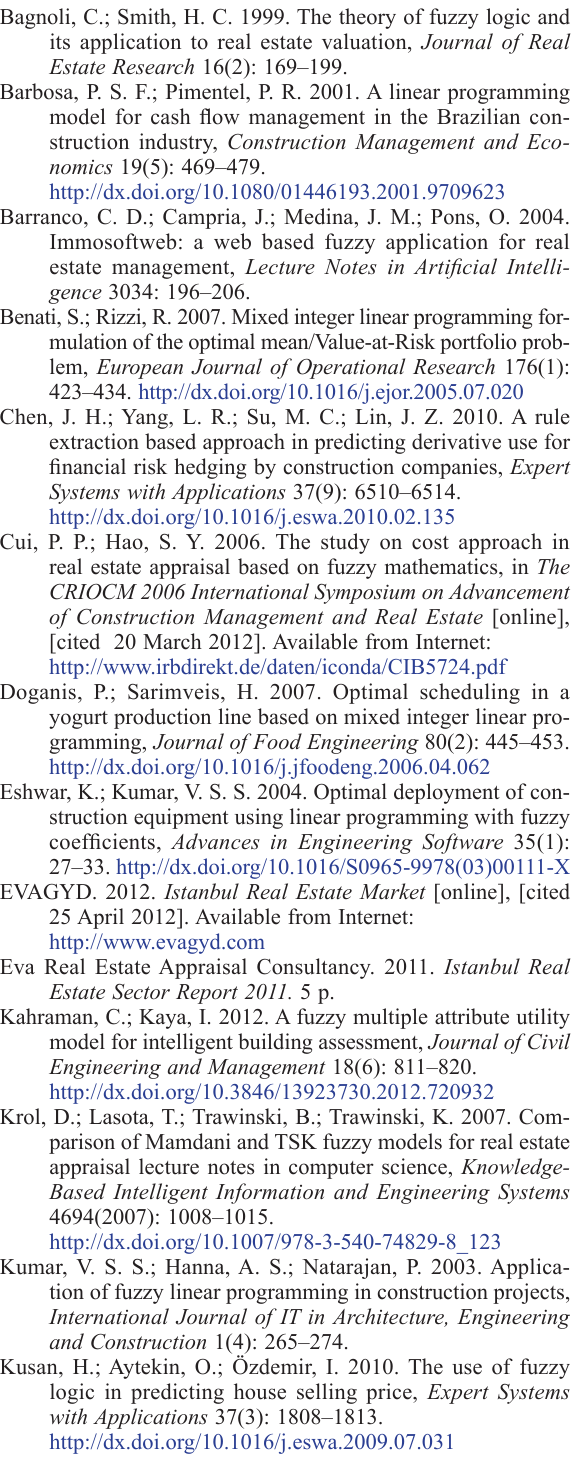
Table 7. ANOVA for number of residences Dependent Variable: Number of residences